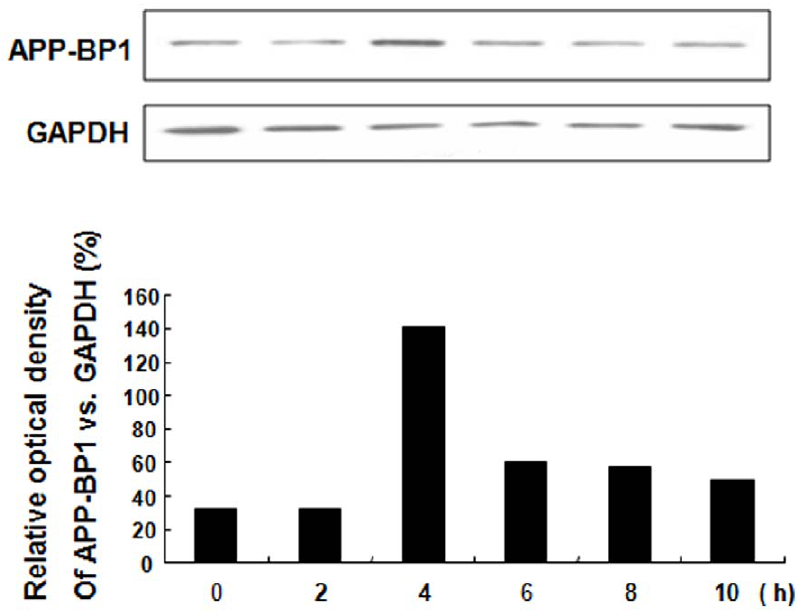
Figure 5. APP-BP1 expression varied according to cell cycle phase. Fetal neural stem cells were synchronized to G1 phase by treatment with 2 mM thymidine for 16 h, and then released from cell cycle arrest by replacing the thymidine-containing media. Cells were harvested at 0, 2, 4, 6, 8, 10 and 12 h, and APP-BP1 protein levels were examined by Western blotting. The blot is representative of three independent experiments. The protein level of GAPDH was examined as a loading control.